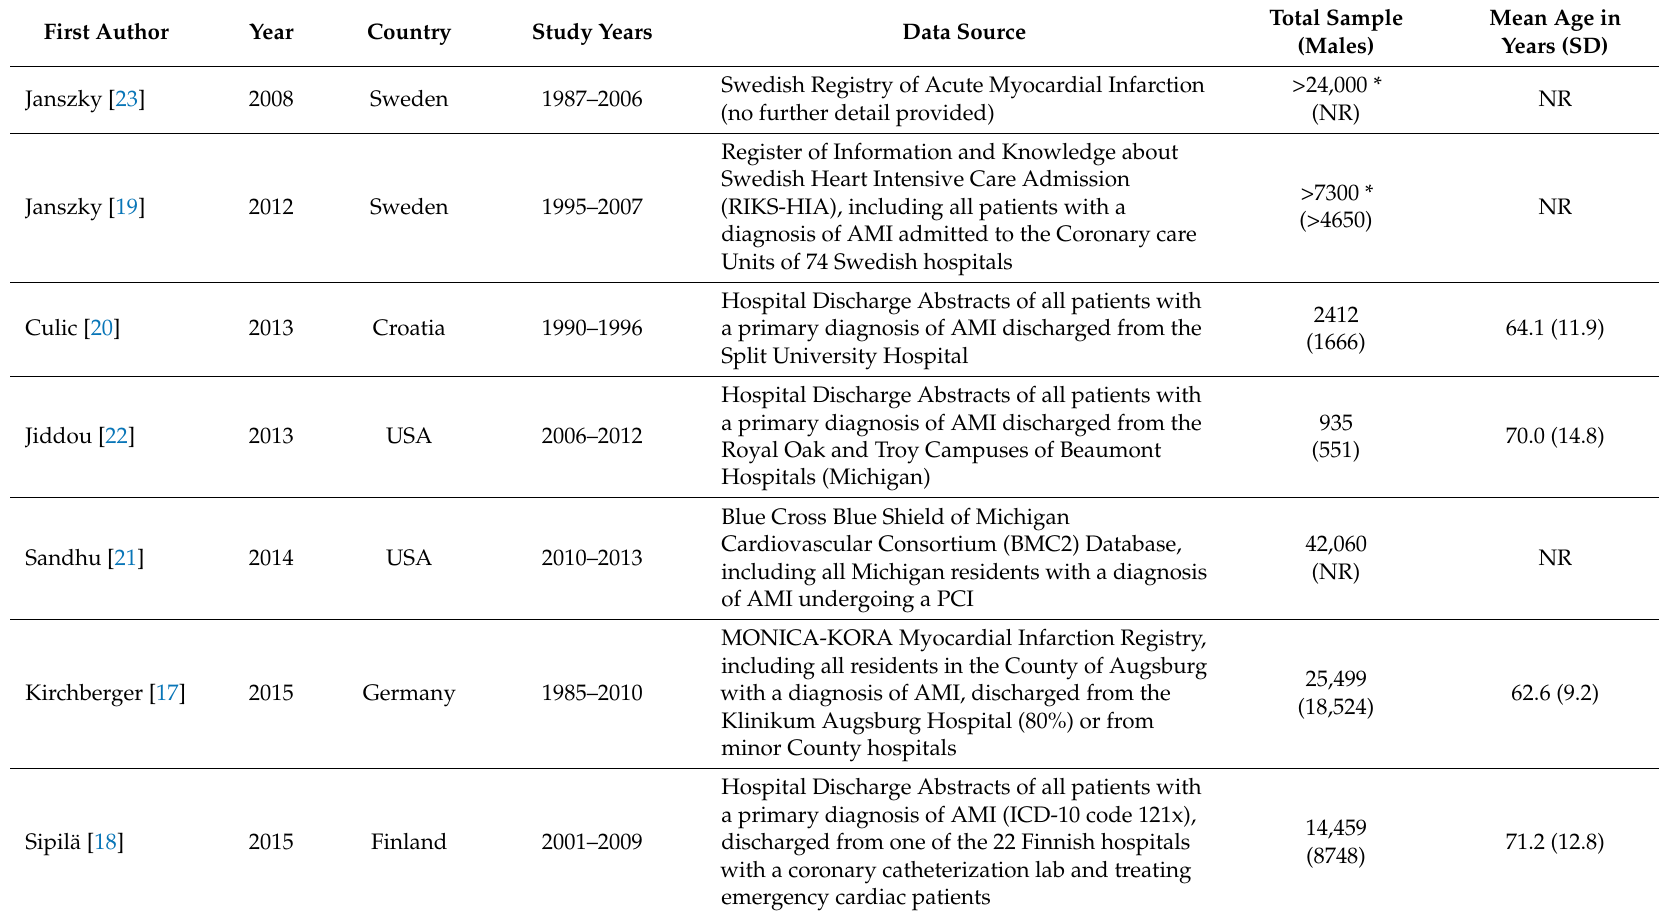
Table 2. Characteristics of the included